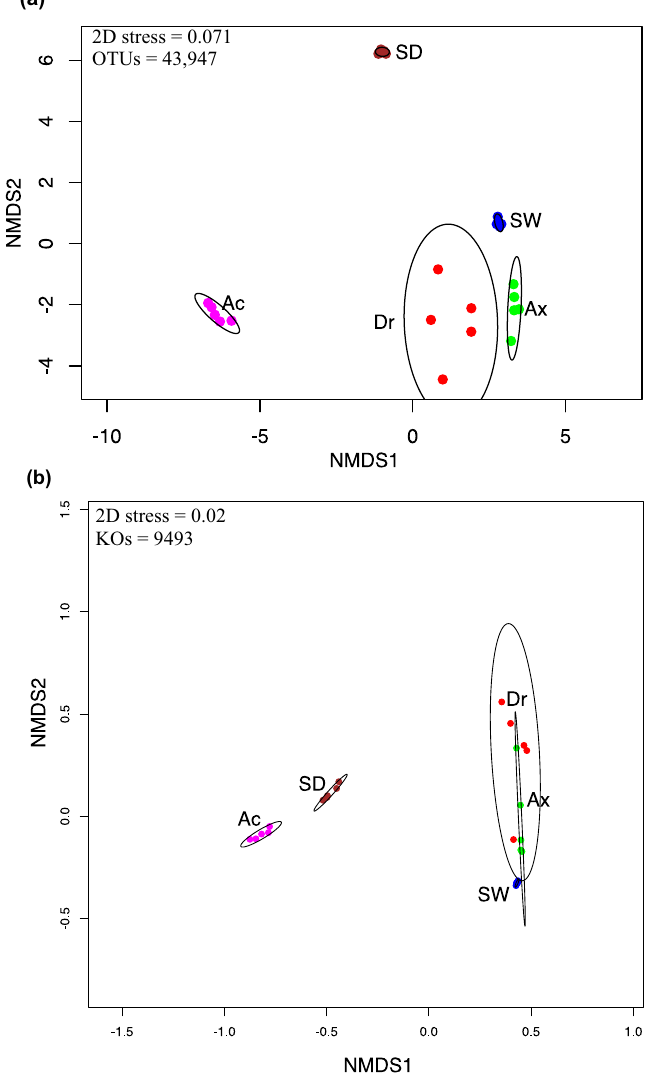
Figure 5. Non-metric multidimensional scaling (nMDS) plots. (a) nMDS based on Bray–Curtis distances calculated from the normalized 97% OTU table and (b) predicted KEGG Orthologs for each sponge species, seawater, and sediment. Ap. caissara (Ac), Ax. corrugata (Ax), D. reticulatum (Dr), seawater (SW), and sediment